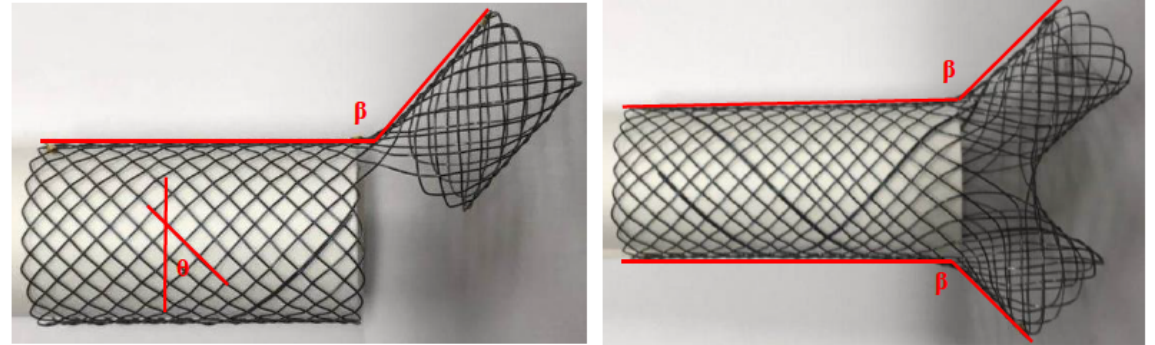
Figure 1: The angle between the branches and stem in (a) J-shaped stent and (b) Y-shaped